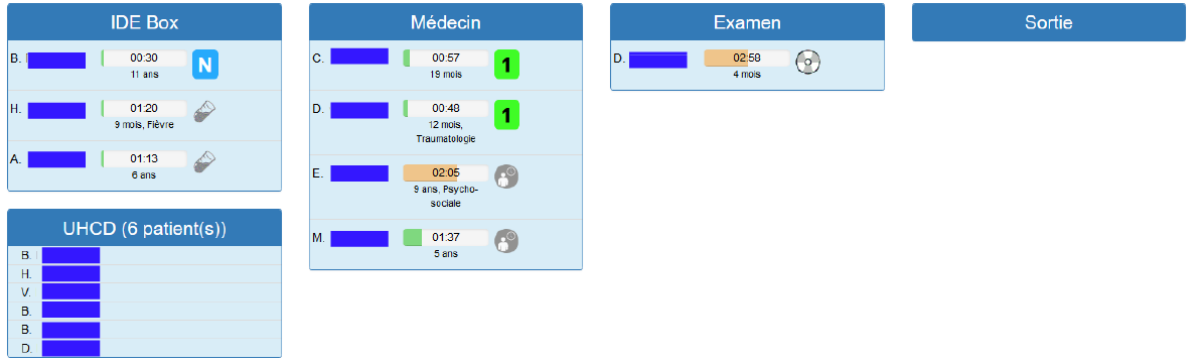
Figure 8. Screenshot of the prototype patient prioritization tool after re-engineering (blue rectangles hide patient